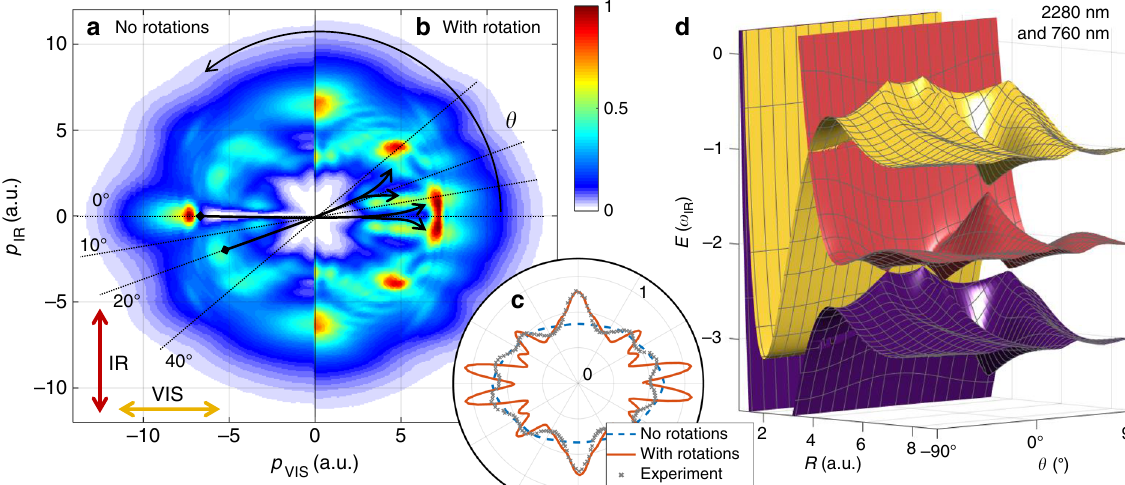
Fig. 3 Numerical results for two-color bond softening of H 2 + . Proton momentum distributions obtained from solving the time-dependent Schrödinger equation a without and b with rotational dynamics taken into account. The colorbar represents the proton yield per momentum bin. The black arrows indicate population transfer through rotational dynamics. The dotted black lines at various angles are drawn as a guide to the eye. c The calculated proton angular distributions are compared to the measured data presented in Fig. 2b. Each angular distribution is integrated over kinetic energy and normalized to its integral. The error bars (s.d.) for the experimental data are of the same size as the symbols. The calculations have been averaged over a delay range corresponding to one mid-IR cycle around the temporal overlap between the few-cycle visible pulse with the center of the mid-IR pulse. d The LIP energy landscape obtained from Floquet theory for a two-color fi eld with relative phase Δ φ = 0. The nuclear potential energy is plotted as a function of the internuclear distance R , and the angle θ between the molecular axis and the polarization of the visible fi